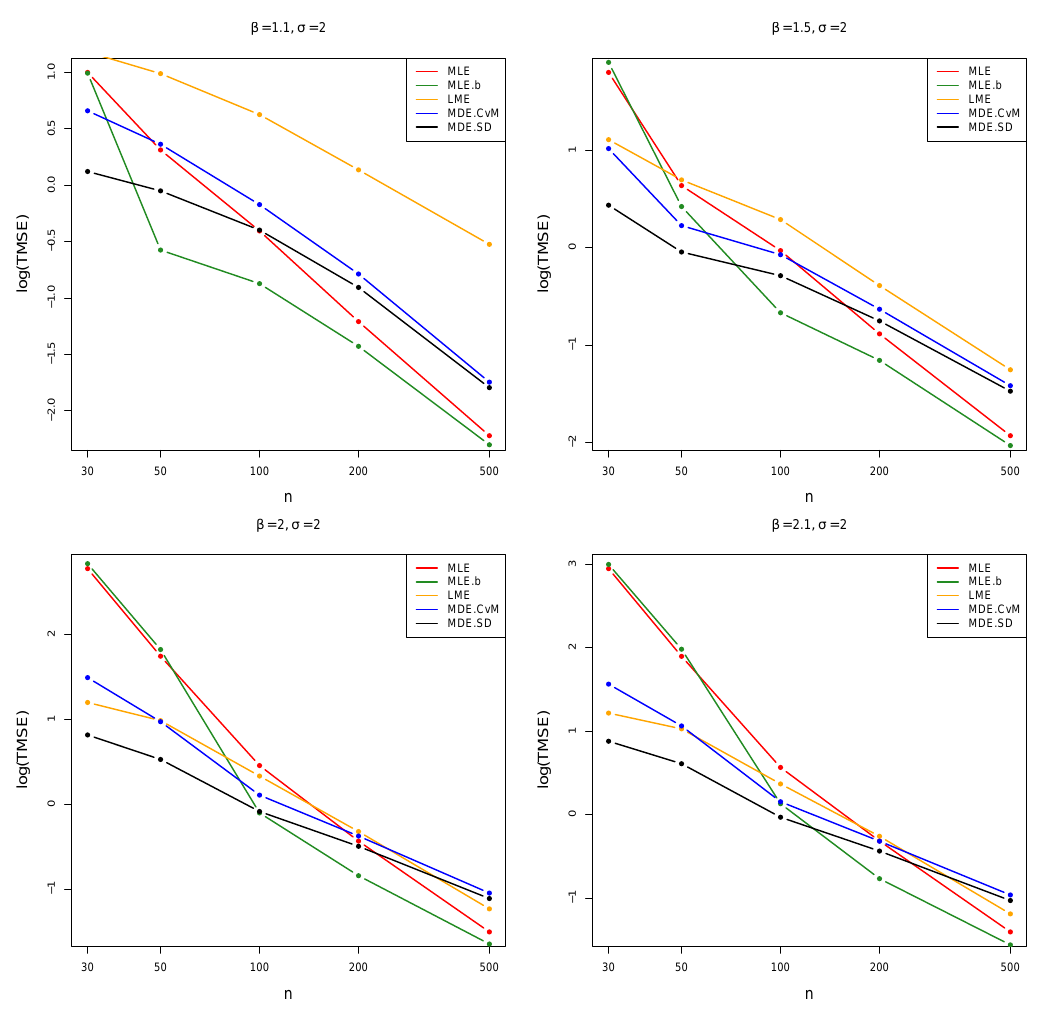
Figure 2. Plots of the log of the trimmed TMSE measure against sample size for five different estimation techniques when σ =